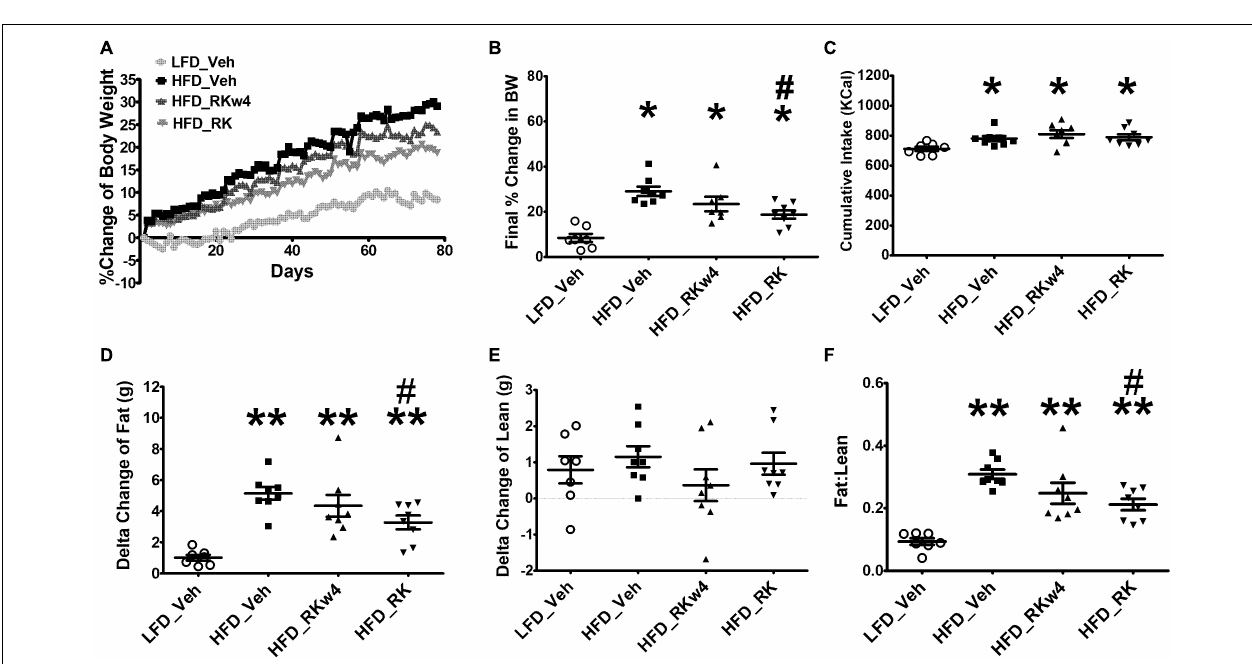
FIGURE 3 | Daily RK (200 mg/kg) dosing prevented body weight gain in male mice. Groups were mice that were fed with a low-fat diet daily oral gavage with vehicle (LFD_Veh), high-fat diet oral gavage with vehicle (HFD_Veh), oral RK dosing initiated at 4 weeks of HFD (HFD_RKw4), and HFD and oral gavage RK initiated at the same time (HFD_RK). (A) Percent change of body weight from baseline over 78 days of diet intervention and daily dosing. (B) Percent change of body weight at Day 78. (C) Cumulative Kcal intake over 78 days. (D) Difference from Day 0 to Day 79 in fat mass and (E) Lean mass measured by EchoMRI, and (F) Fat: lean ratio.